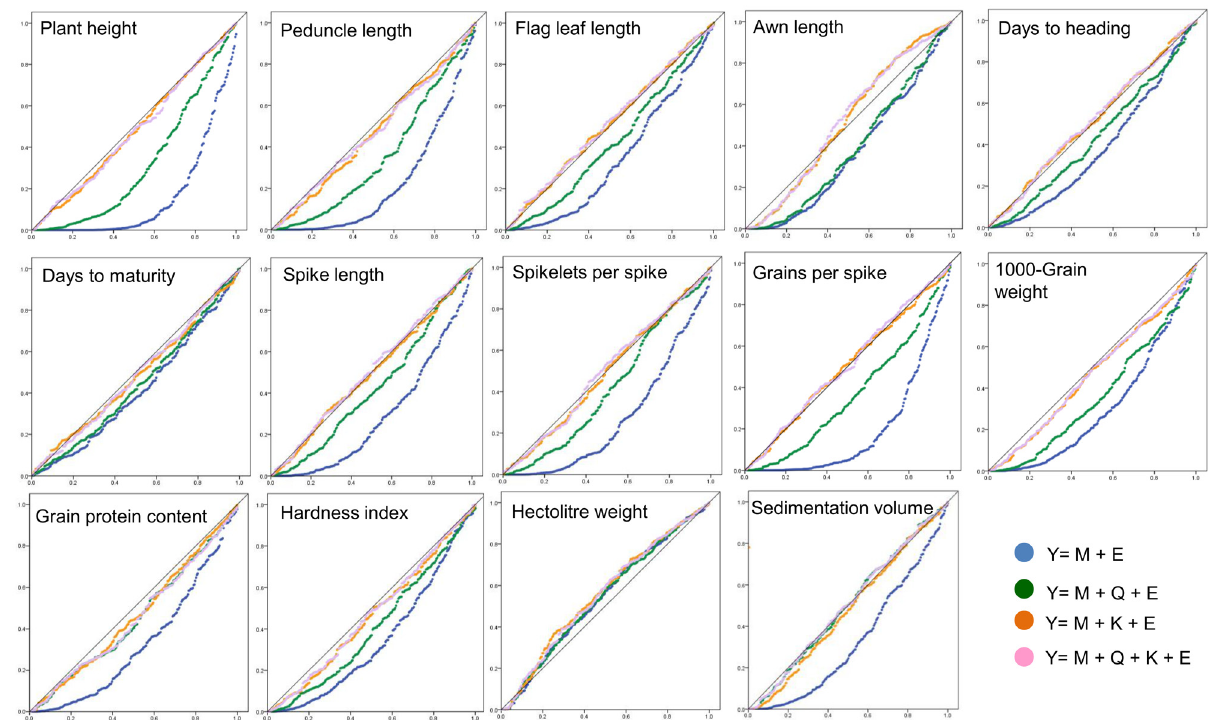
Fig 2. Plots of observed p-values (on y-axis) vs. expected p-values (on x-axis) for the 14 different traits using different association mapping models.